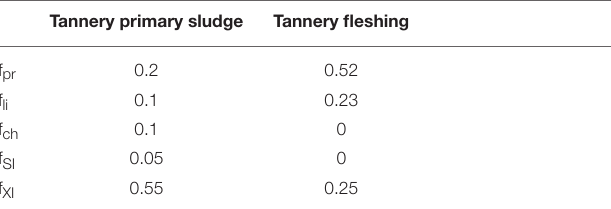
TABLE 3 | Stoichiometric parameters for the disintegration step of TPS and TF. TABLE 4 | Calibrated parameters for disintegration in Experiment 1 and